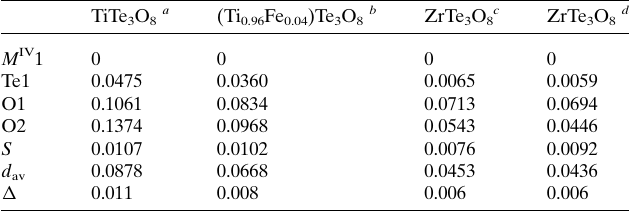
Table 2 Atom pairs and their absolute distances | u | (A˚ ) in the isotypic series M Te 3 O 8 with SnTe 3 O 8 as the reference structure, as well as degree of lattice distortion ( S ), arithmetic mean of the distances ( d av , A˚ ) and measure of similarity ( (cid:3) ).